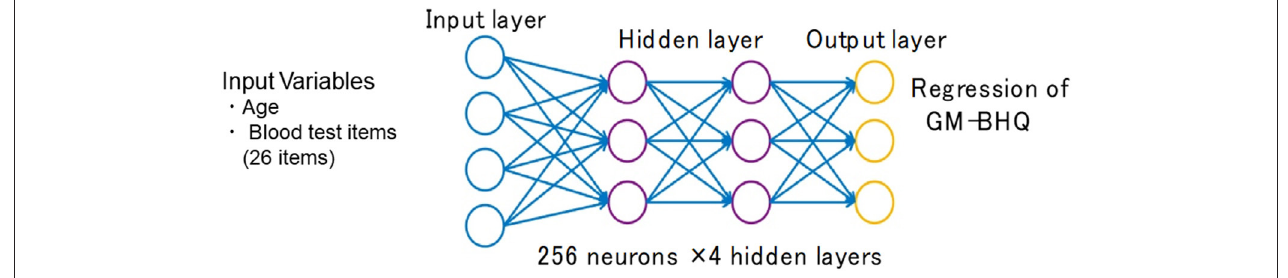
FIGURE 2 | Structure of the deep neural network for data analysis. The input vectors included age, sex, and blood test data. The output vector was regressed to estimate GM-BHQ. The hidden layer contained no backward connections from the downstream layers.